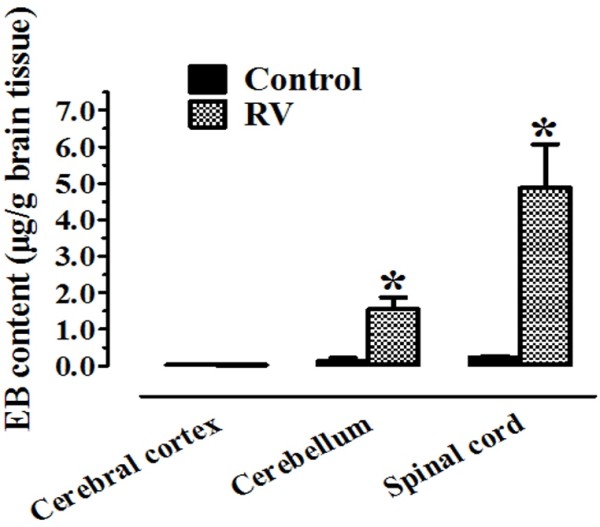
Localization of BBB permeability changes in the brain of rabies virus-infected rats. Brains were removed from Evans blue-treated rats either in the control or rabies virus-infected animals on day 10 to 11 p.i.. BBB permeability was assessed by measuring the EB content which was determined by a standard curve. Compared with controls (n = 4), rabies virus-infected rats (n = 8) showed a significant increased in the amount of EB (*p < 0.05).